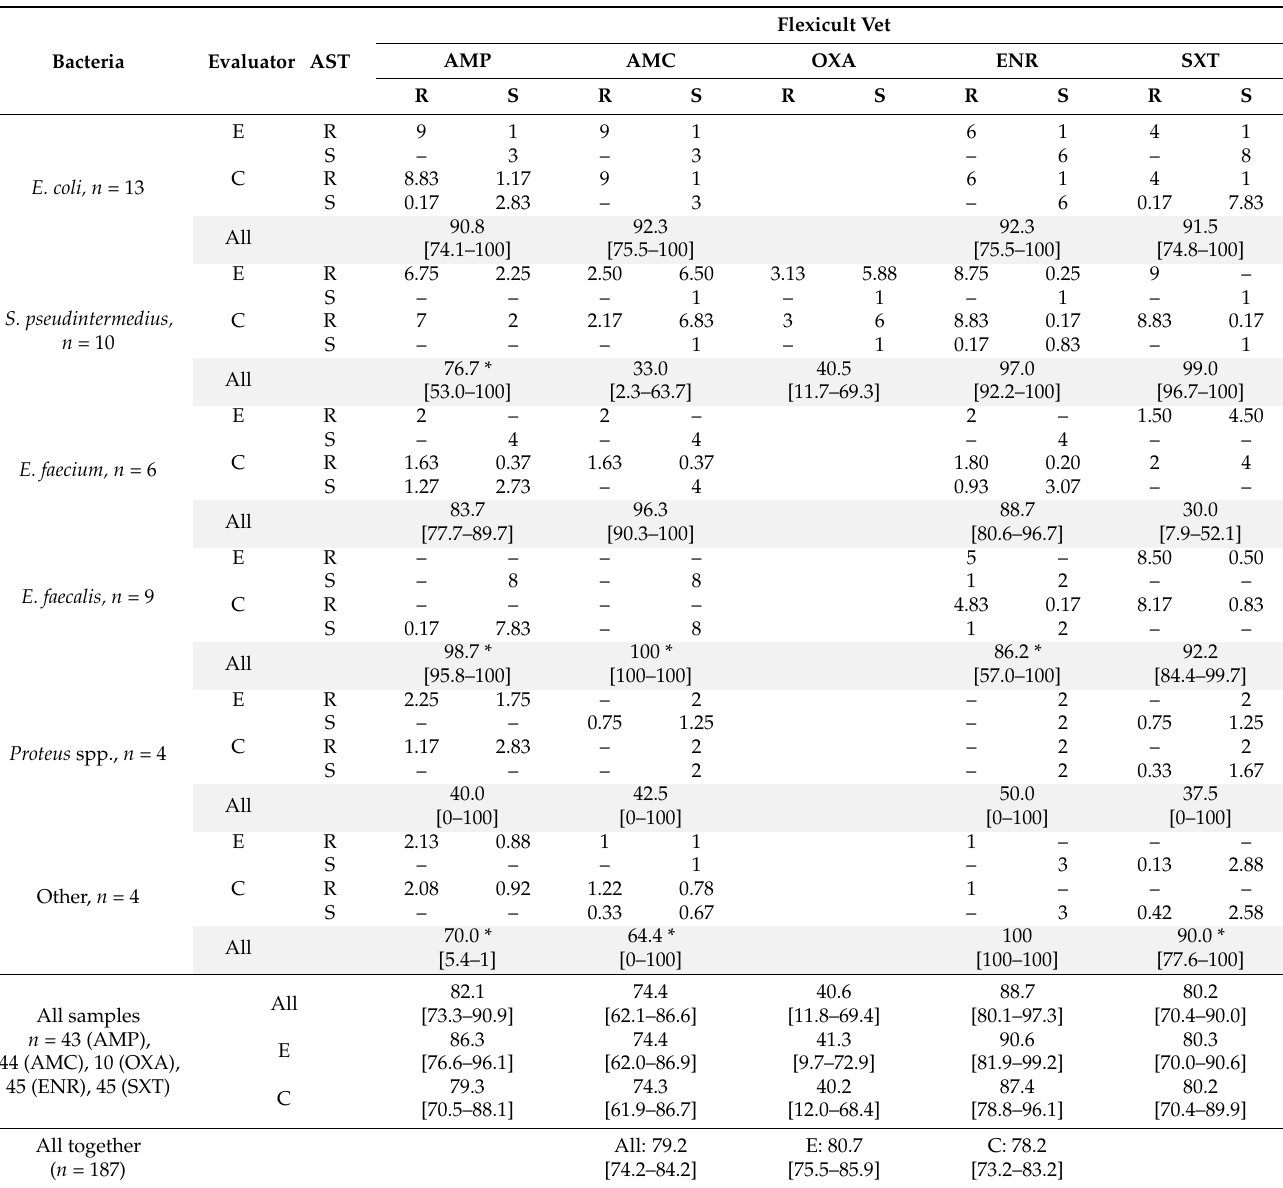
Table 2. Absolute sample counts and AST accuracy (in %, means and 95% confidence intervals, CI, in the squared brackets) for Flexicult Vet, evaluated by experts (E) and clinicians (C). Antibiotic abbreviations are the following: ampicillin (AMP), amoxicillin (AMC), oxacillin (OXA), enrofloxacin (ENR), trimethoprim/sulfamethoxazole (SXT). * denotes a group with one sample